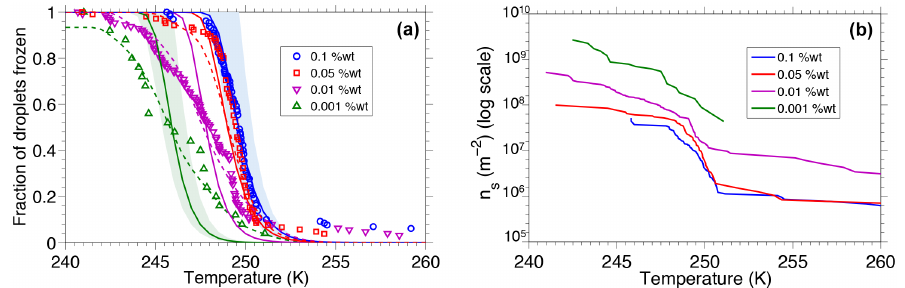
Figure 7. (a) Experimental freezing curves for different mass concentrations of MCC cellulose powder immersed in 500–700µm diameter water droplets obtained using the CMU cold plate (circles). Dashed lines are fits produced from randomly sampling from the g distribution retrieved from the highest concentration freezing curve (0.1wt%, blue solid line) and a surface area correction. The second highest concen- tration freezing curve (0.05wt%, red) is used to confirm the critical area threshold was exceeded. The shaded region represents the effect of variability in surface area as in Fig. 5 but for a droplet diameter range of 500–700µm for the highest and lowest particle concentration experiments. (b) Ice active site density ( n s ) retrieved from the frozen fraction data on the left. A trend of increasing n s with decreasing concentration is